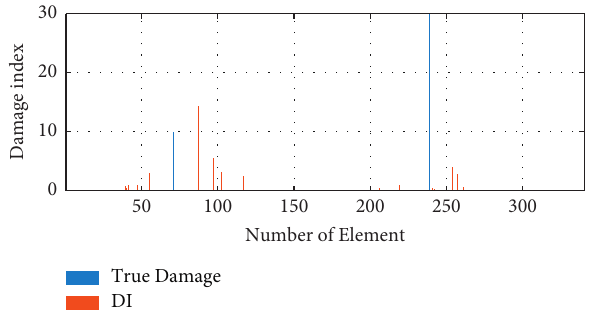
Figure 24: Results of damage scenario D5 using incomplete mode shapes.